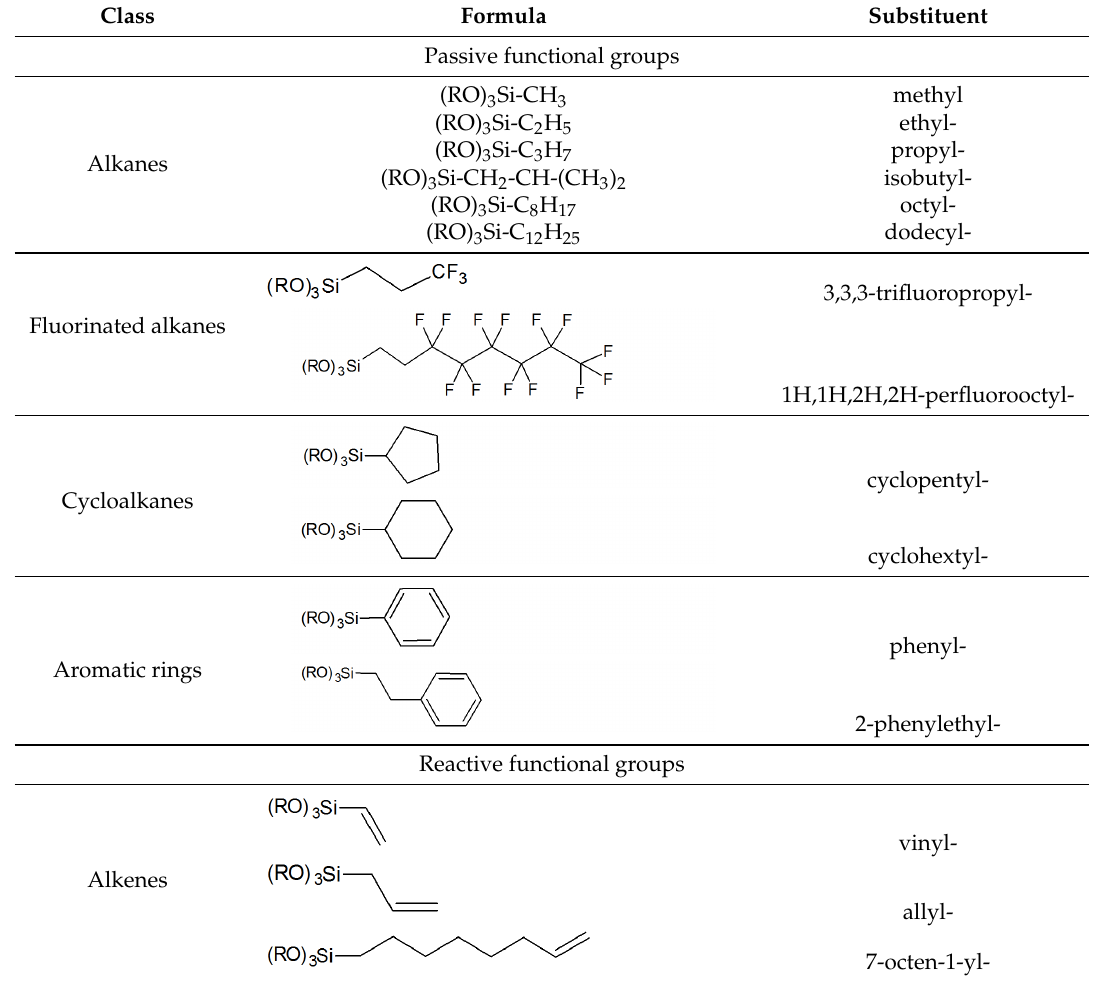
Table 2. The most used trialkoxyorganosilanes for silica surface